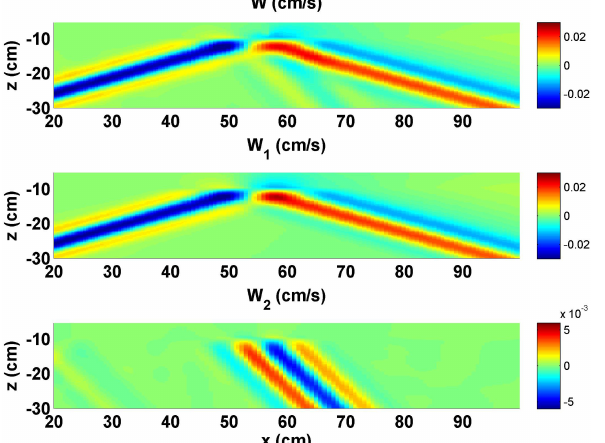
Figure 7. Snapshot of the vertical velocity field (top) for the simu- lation with θ = 40 degrees and r = 2 . 5. Time-filtered velocity fields for the ω f (middle) and 2 ω f (bottom) bands show the trapped har- monic